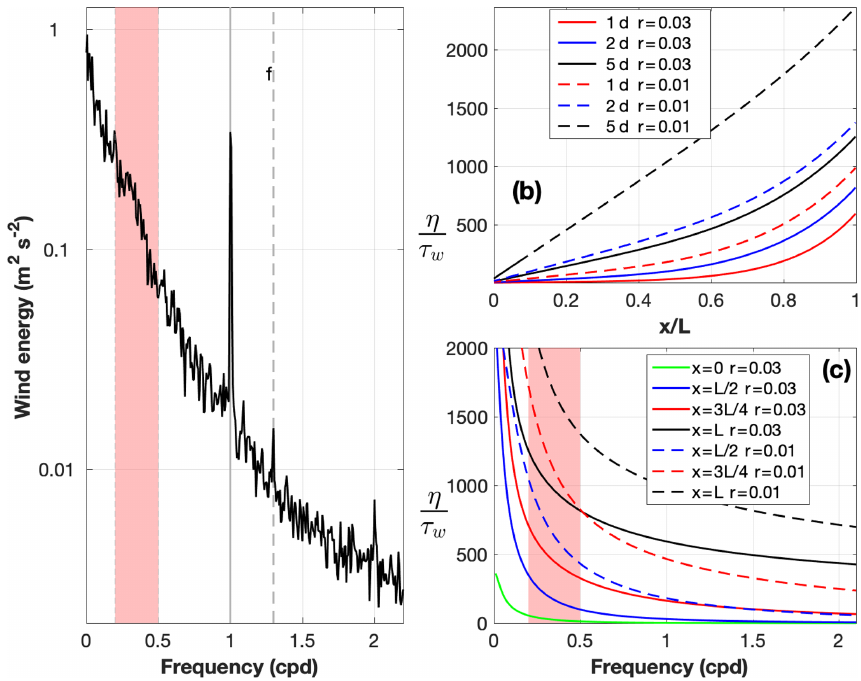
Figure 7. (a) Wind speed spectra for the along-bay wind component for NDBC 44065 buoy (2008–2018). (b) Kinematic wind stress contri- bution to local water level in the bay expressed as η/τ w (m − 1 s 2 ) , following the Wong and Moses-Hall (1998) formulation, as a function of distance from the southern edge of the bay ( x/L = 1 is the northern edge of bay). (c) Kinematic wind stress contribution to water level as a function of frequency. The vertical shaded area indicates the frequencies corresponding to the storm band (2–5d).